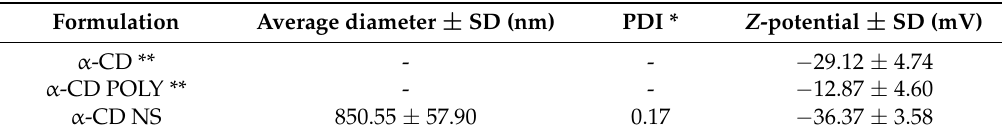
Table 1. Physio-chemical characterization of an α -CD formulation. Each point represents the mean ± SD of the three different formulations ( n = 3).